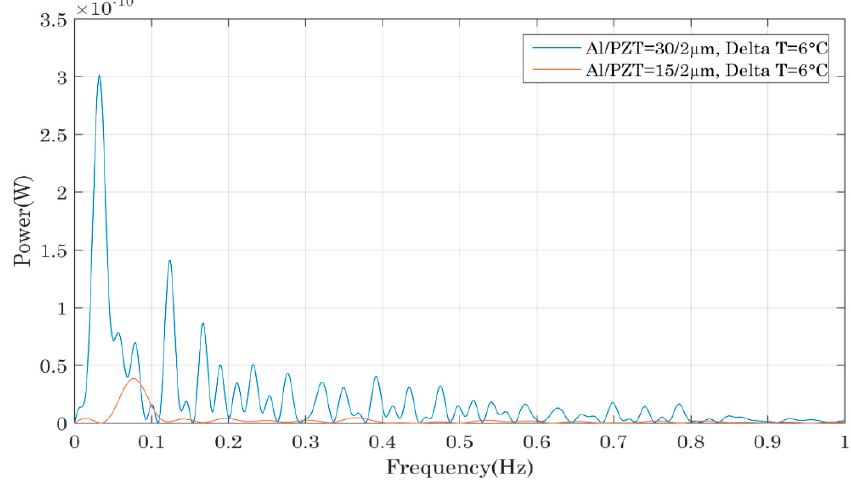
Figure 9. Impact of the Al foil thickness on the output power of the piezoelectric bimetal mounted in the device shown in Figure 7.